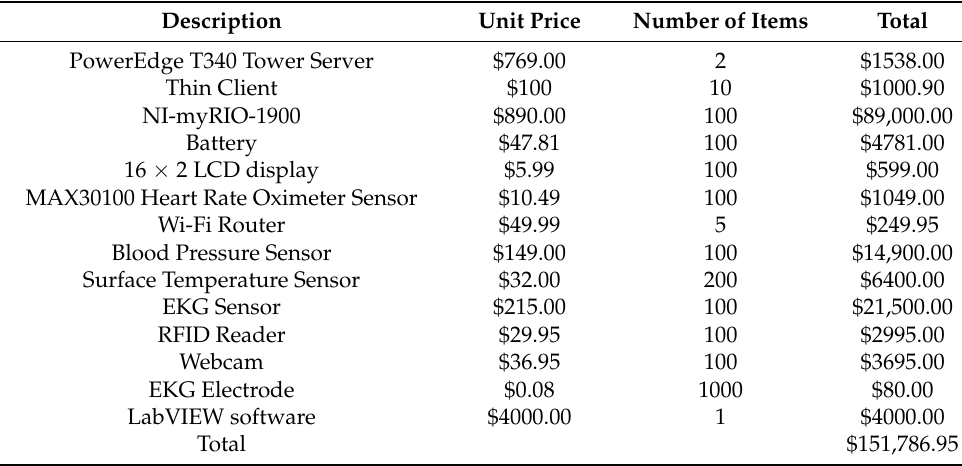
Table 2. Cost analysis for monitoring 100 patients using LI-Care.